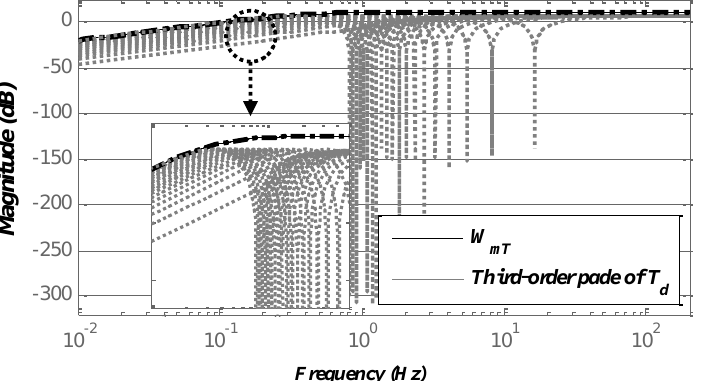
Figure 8b. Bode diagram of the multiplicative weight function W mT for third order Pade  approximation of time